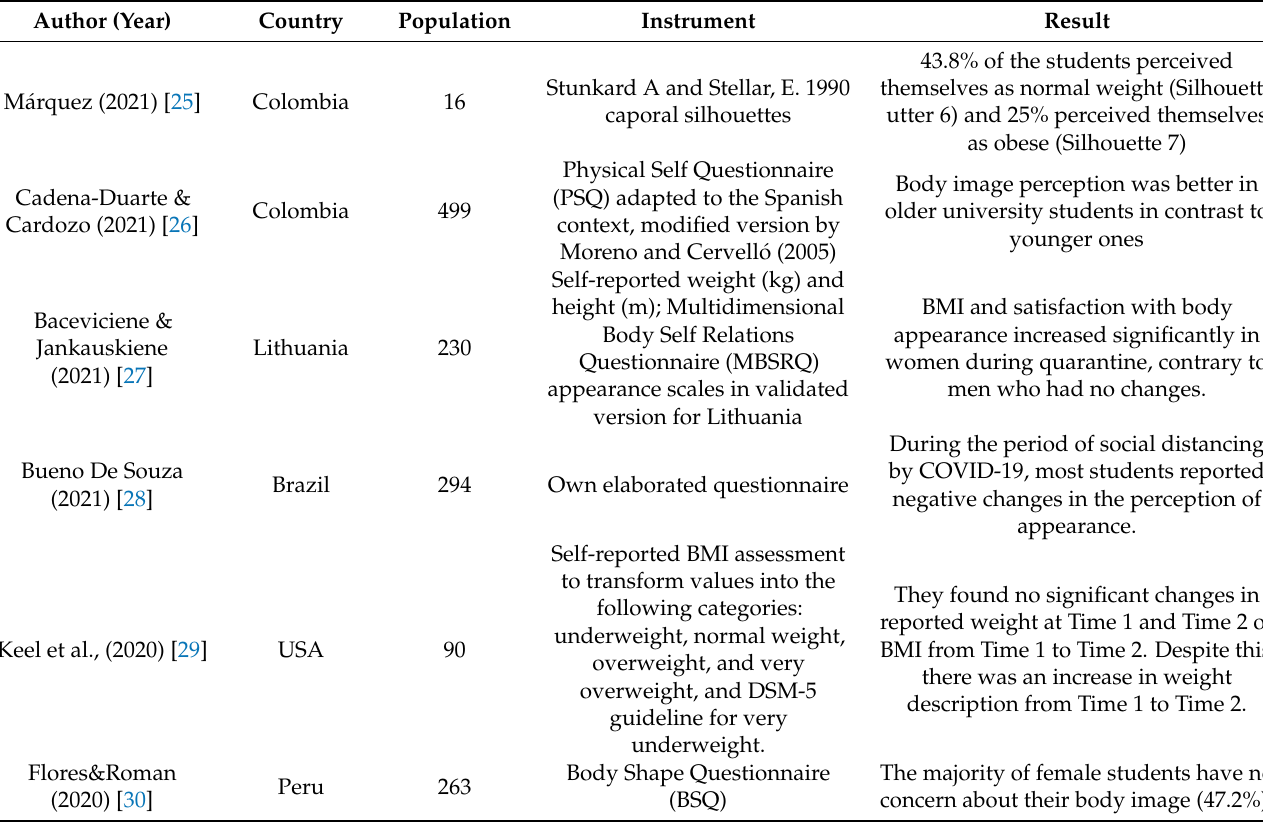
Table 3. Body Image in university students during